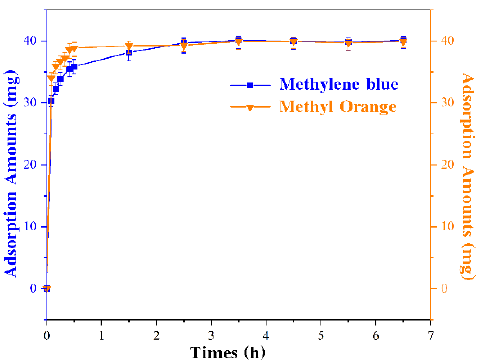
Figure 5. Adsorption capacity of N-doped porous carbons of methylene blue and methyl orange .